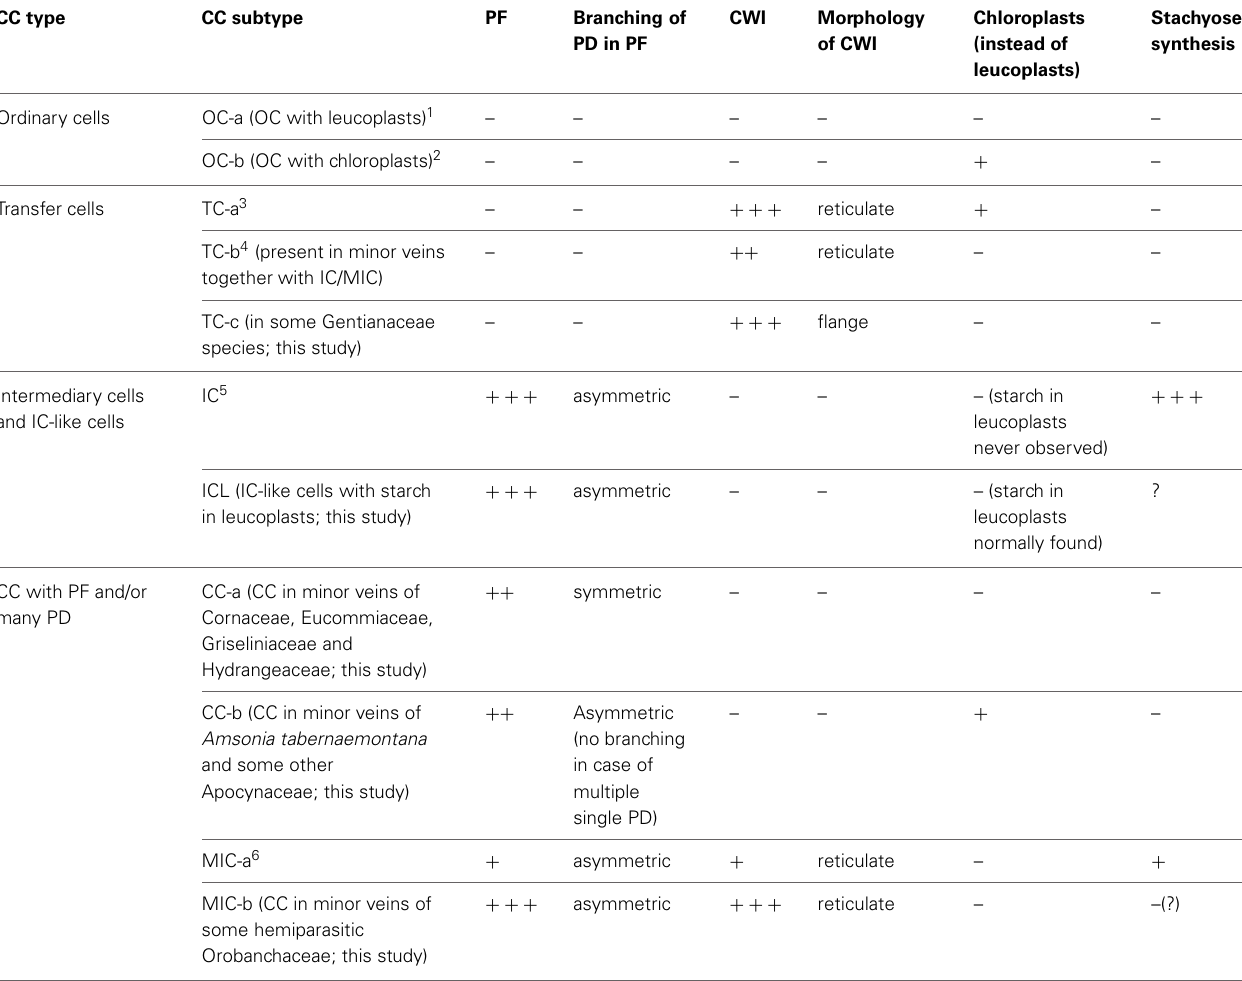
Table 1 | Classification of companion cells in Asteridae according to their structural